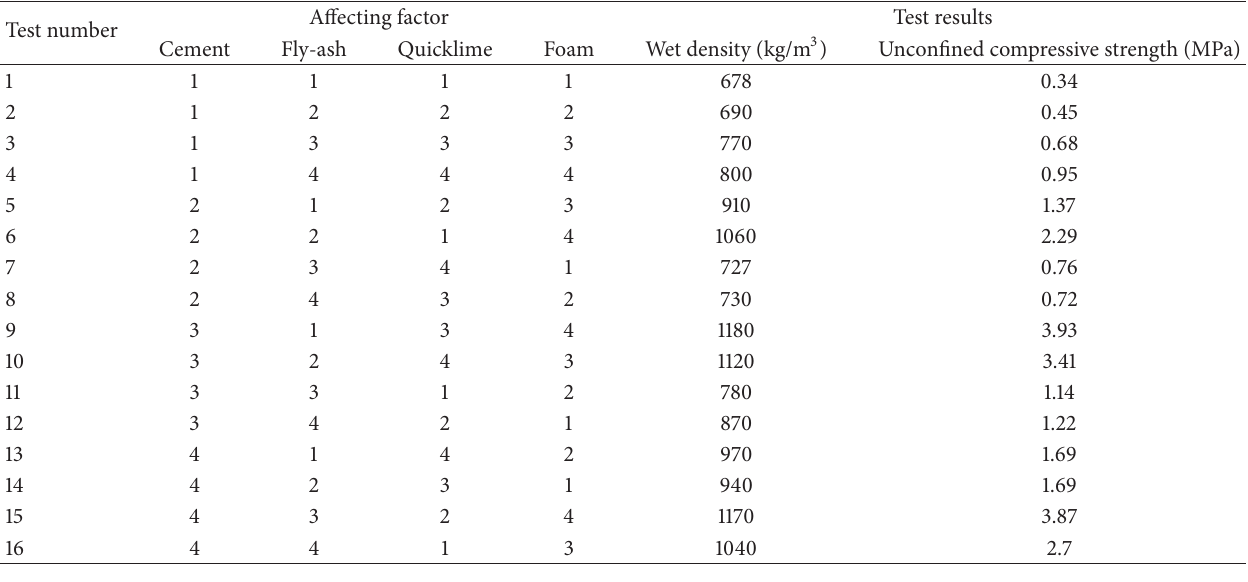
Table 2: 𝐿 16 (4 4 ) orthogonal table.